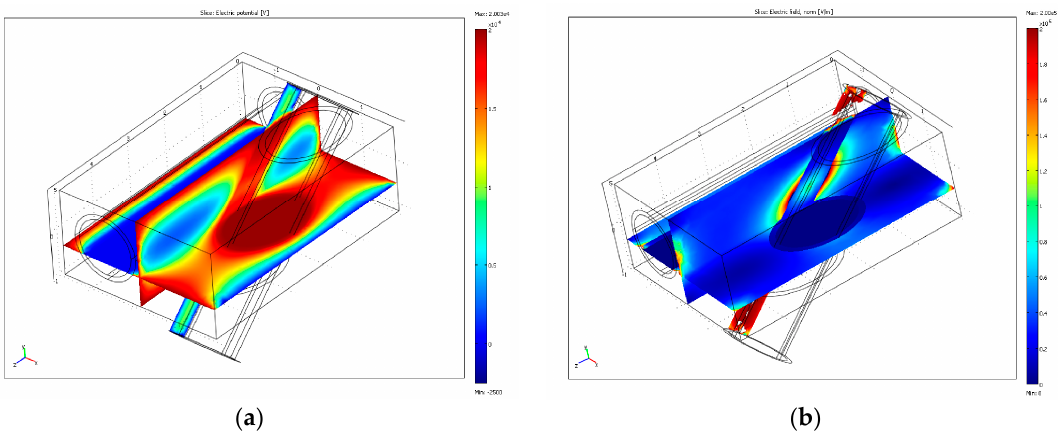
Figure 14. The 3D electric potential ( a ) and electric field strength ( b ) distribution in twisted-pair with wire diameter 0.7 mm, for α = 45 ◦ , at 2 kV.